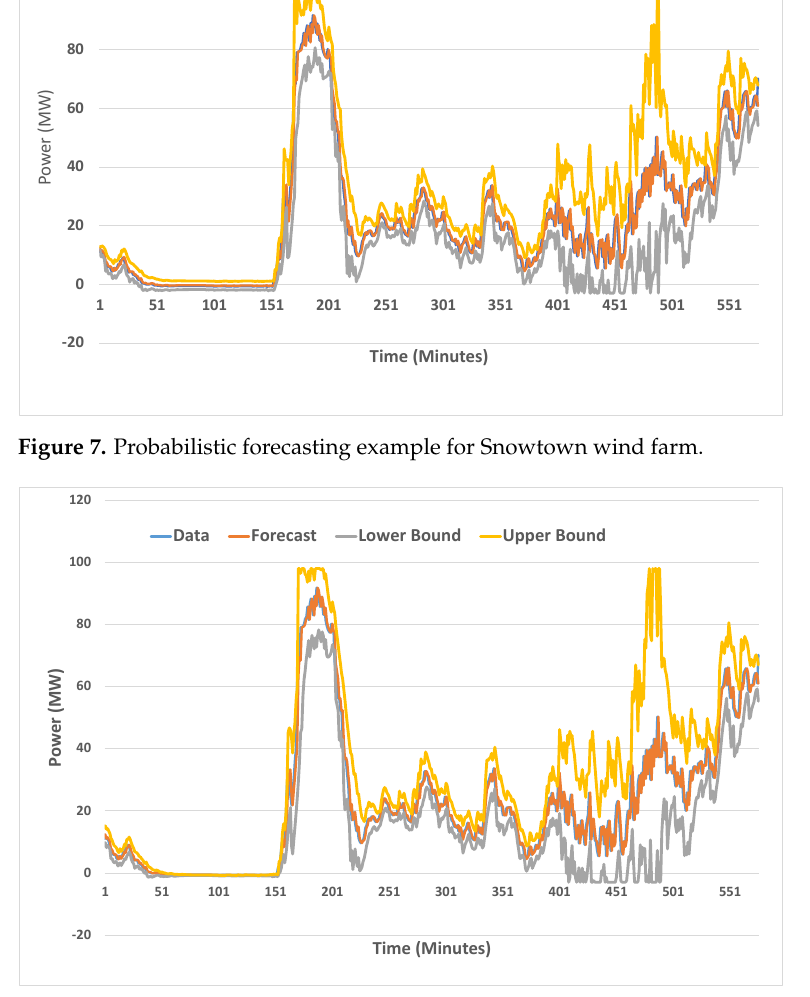
Figure 8. Probabilistic forecasting example for Snowtown solar farm (Persistence). Table 1. Wind farm coverage and interval score for different confidence levels—comparison with